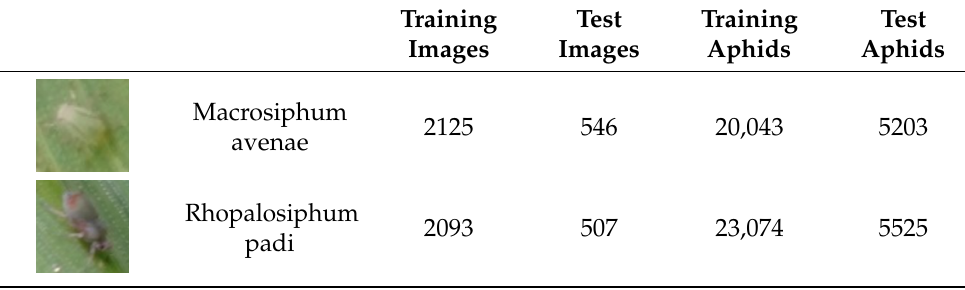
Table 1. The constitution of the APHID-4K